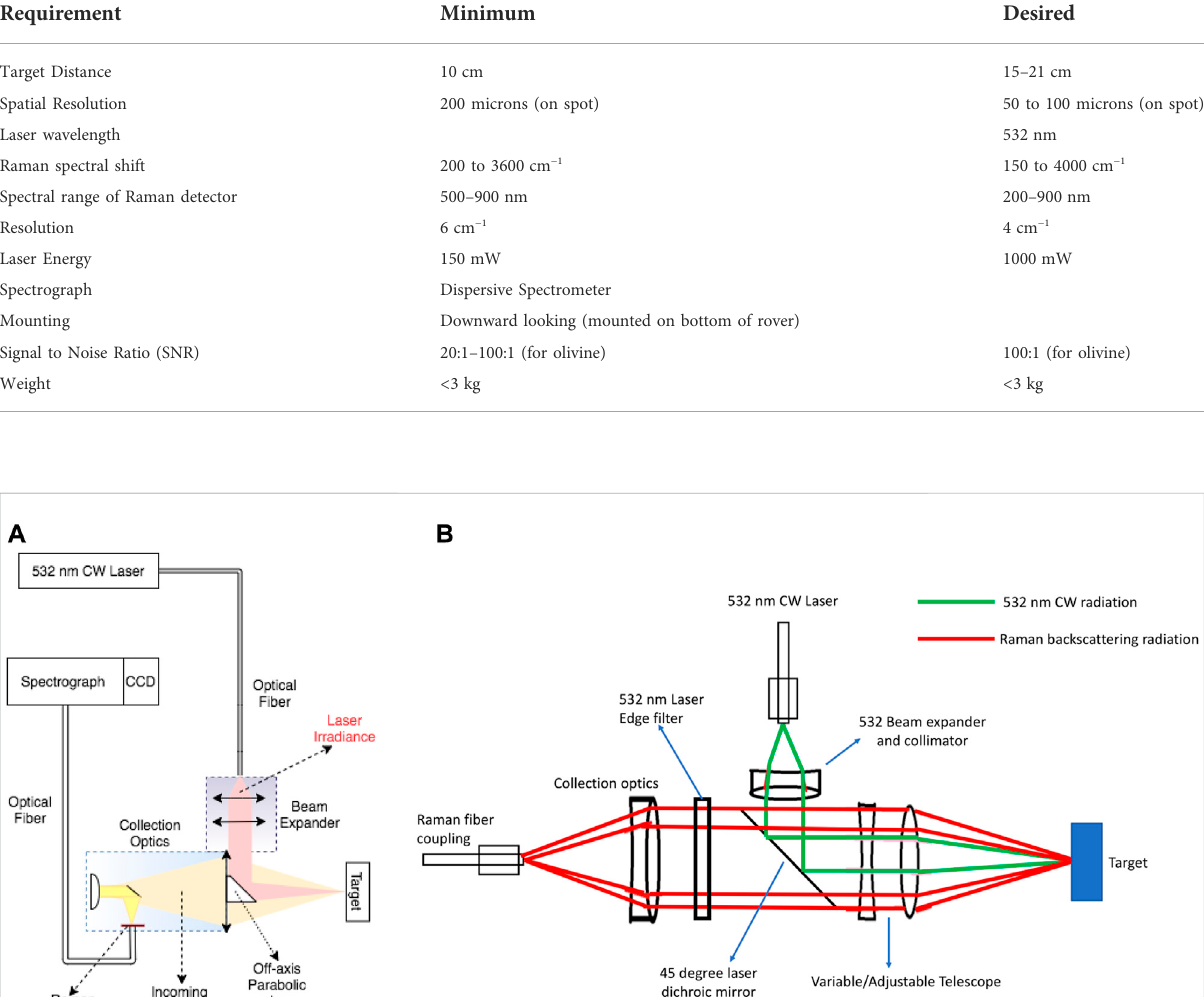
TABLE 4 Selected LunaR instrument and performance